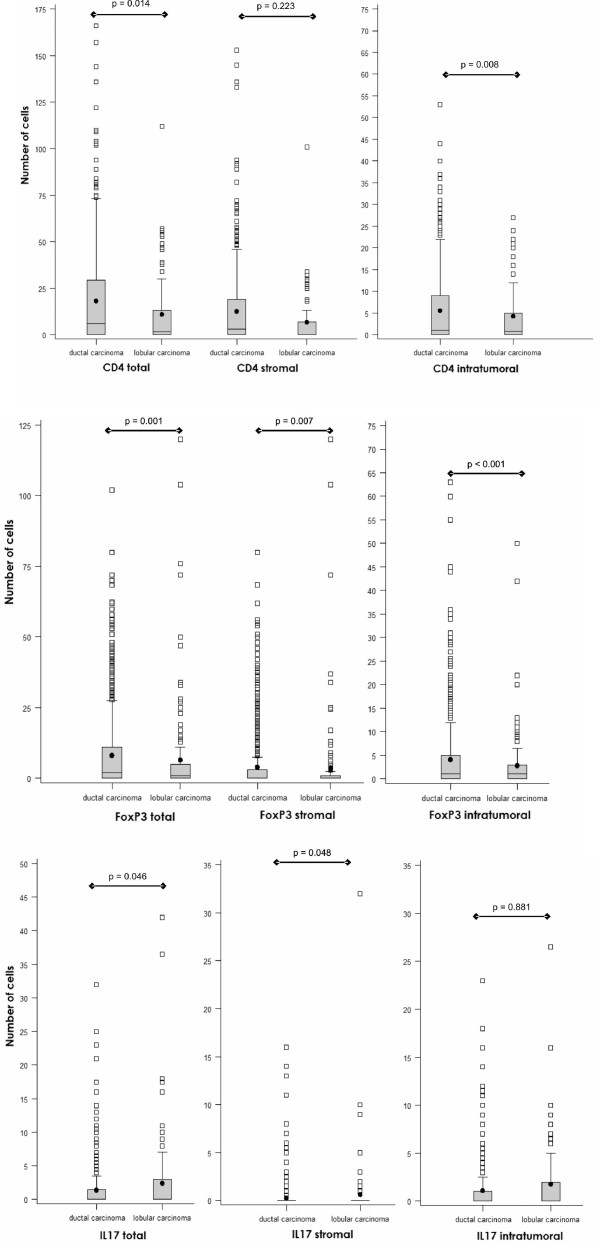
Box plot analysis of CD4+, FOXP3+ and IL-17+ cell distribution in ductal versus lobular carcinoma. Box plot analysis of lymphocyte infiltration in ductal versus lobular carcinoma for CD4+, FOXP3+ and IL-17+ TILs. After adjustment for multiple comparisons, only p < 0.001 was considered statistically significant.